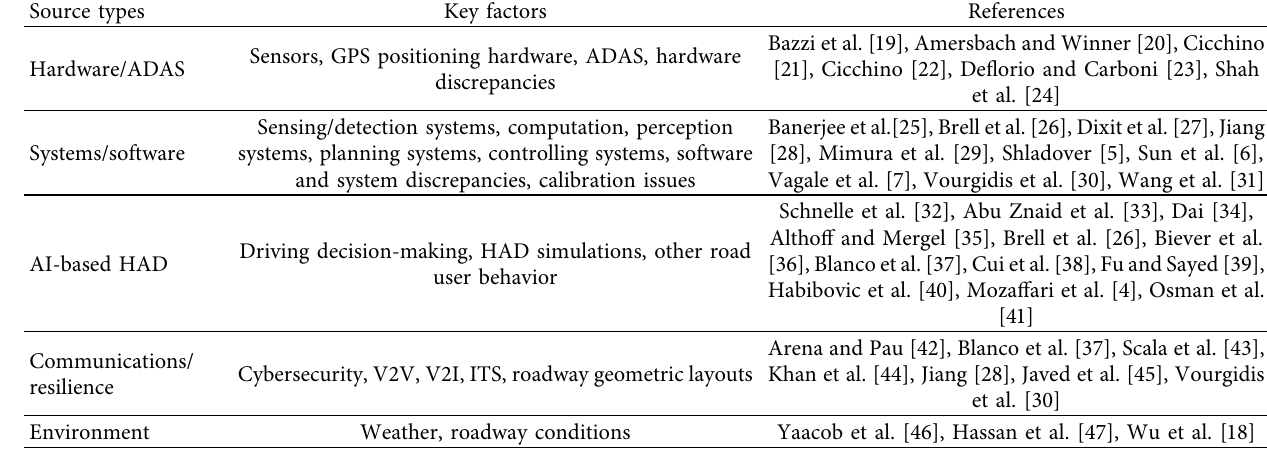
Table 1: Source types and example factors for ADS